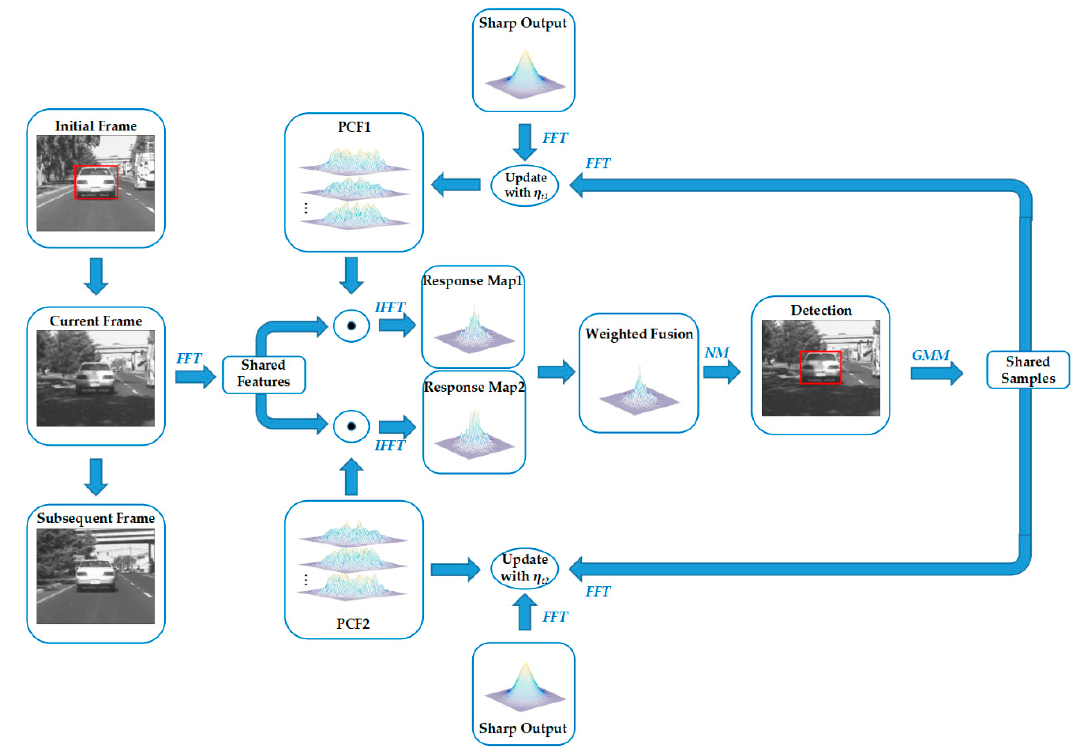
Figure 3. The flow chart of the proposed PCF framework. In the initial frame, the PCF tracker trains two parallel correlation filters PCF1 and PCF2 online in the frequency domain utilizing the shared samples and the sharp correlation output. In the current frame, PCF1 and PCF2 are utilized to track the target respectively. Through weighting the response maps of PCF1 and PCF2, the PCF tracker accurately detects the position of the target by applying the Newton method (NM). It then utilizes the Gaussian mixture model (GMM) to generate a new shared sample set by adding a new sample or merging the two closest samples. It utilizes the new sample set to update the two parallel correlation filters with different learning rates every six frames.